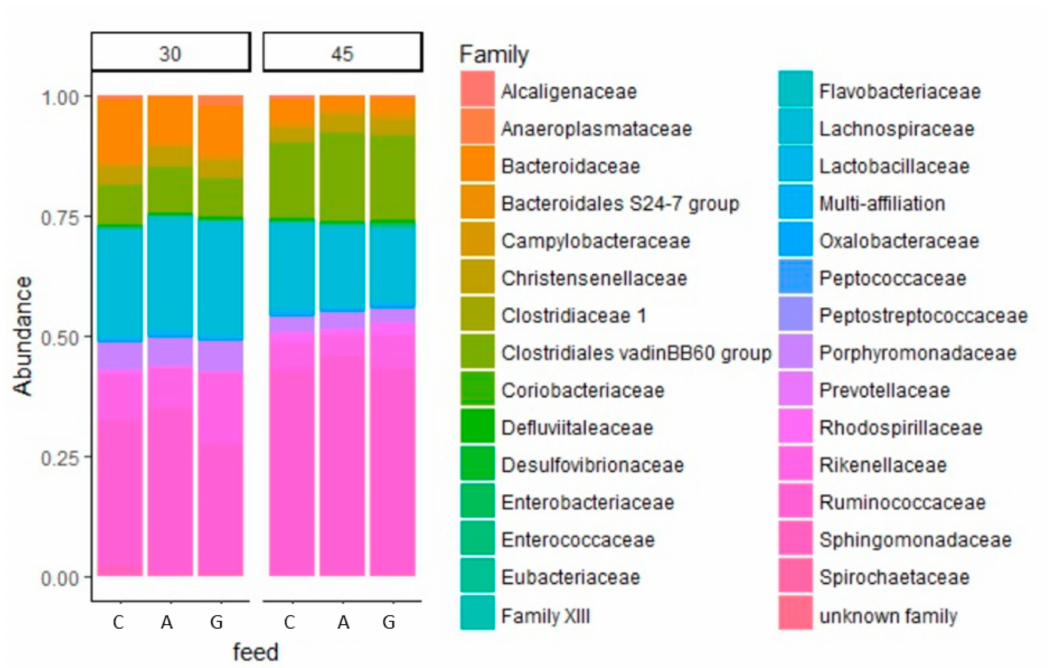
Figure 4. E ff ect of dietary supplementation with dehydrated alfalfa or fresh grass on peri-weaning period on relative abundances (%) of the di ff erent phyla of rabbit caecal microbiota at 30 and 45 days of age. C = rabbit fed pelleted feed only; A = rabbit fed pelleted feed + dehydrated alfalfa; G = rabbit fed pelleted feed + fresh grass.